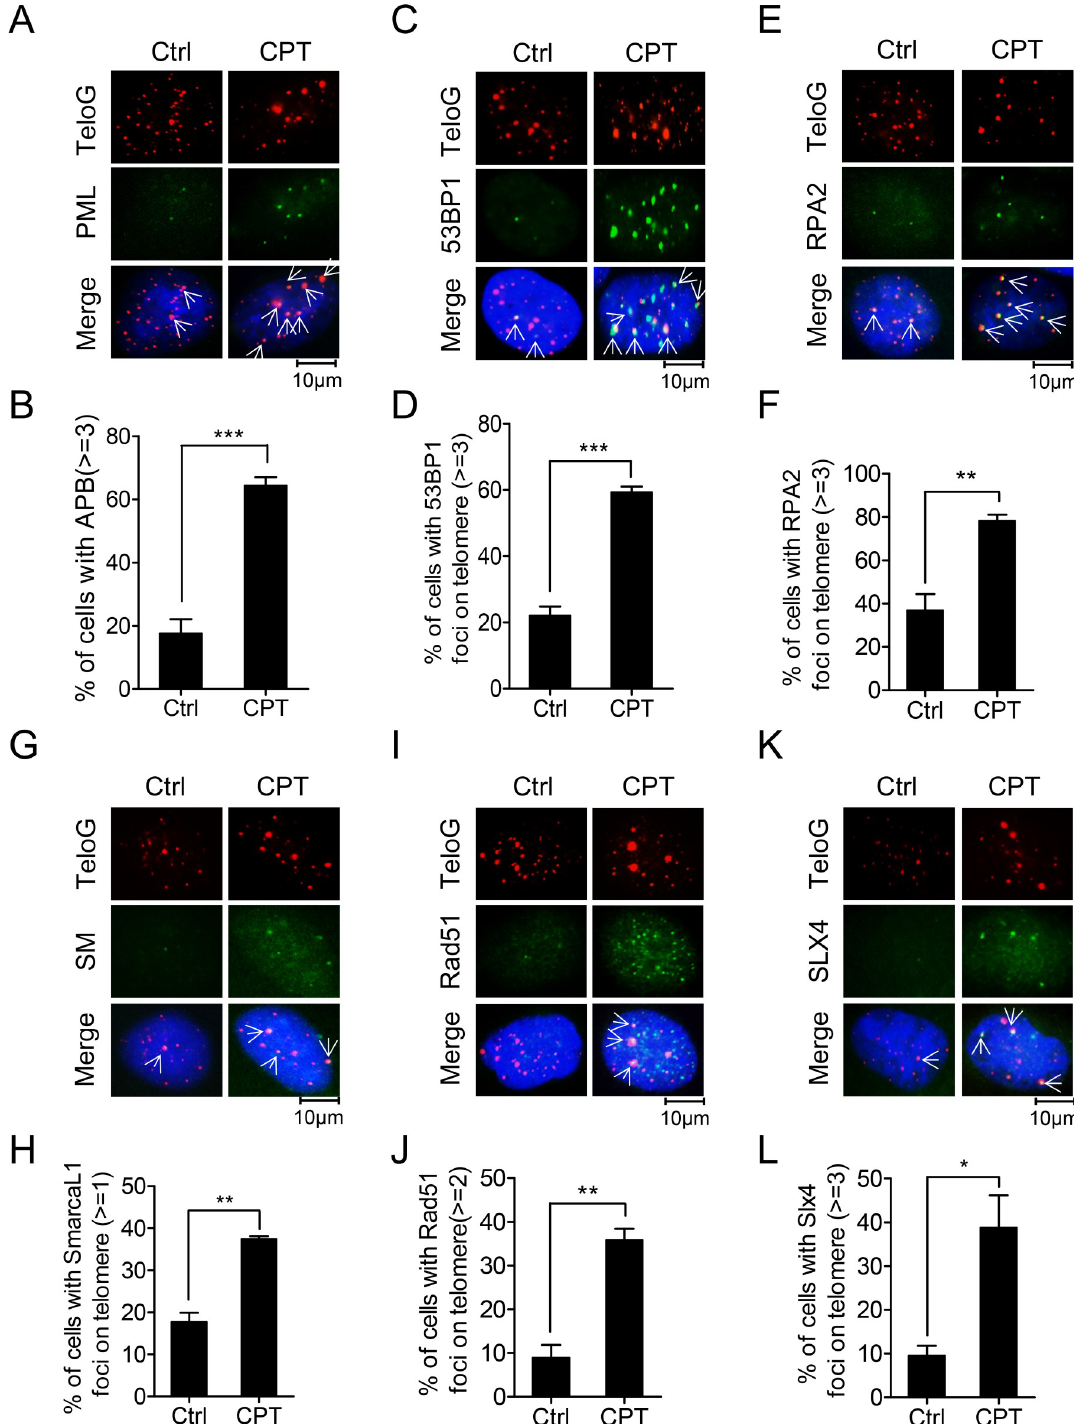
Fig 4. Replication fork collapse and replication fork regression at telomeres in U2OS cells. (A) U2OS cells were cultured in presence or absence of CPT and analyzed with IF-FISH to detect PML bodies on telomeres. (B) Quantification of (A). Cells with � 3APBs were scored. > 100 cells were counted for each experiment. Error bars represent the mean ± SEM of three independent experiments. Two-tailed unpaired student’s t -test was used to calculate P-values. ��� P < 0.001. (C) U2OS cells were treated with or without CPT and analyzed by IF-FISH to detect 53BP1 foci on telomeres. (D) Quantification of (C). Cells with � 3 co-stained foci were scored. > 100 cells were counted for each experiment. Error bars represent the mean ± SEM of three independent experiments.